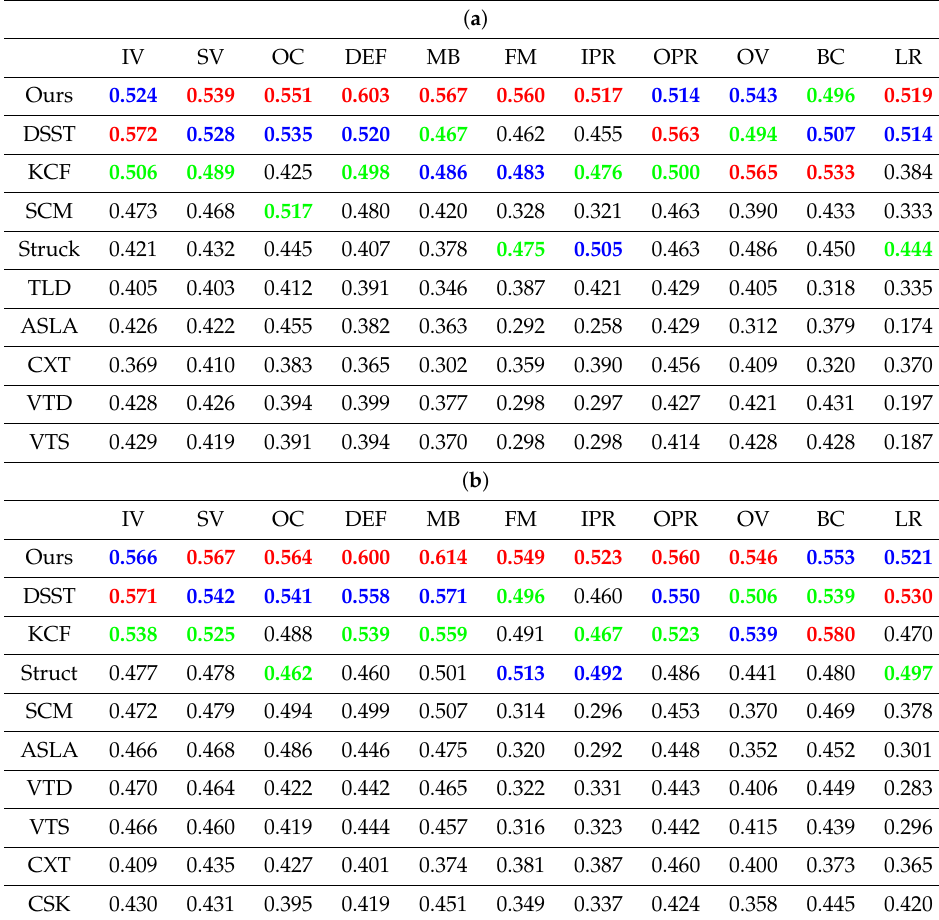
Table 2. The overlap scores on attribute based evaluation. ( a ) scores of trackers based on OPE; ( b ) scores of trackers based on TRE. The texts in the red, blue and green color indicate the first, second and third highest score respectively in every